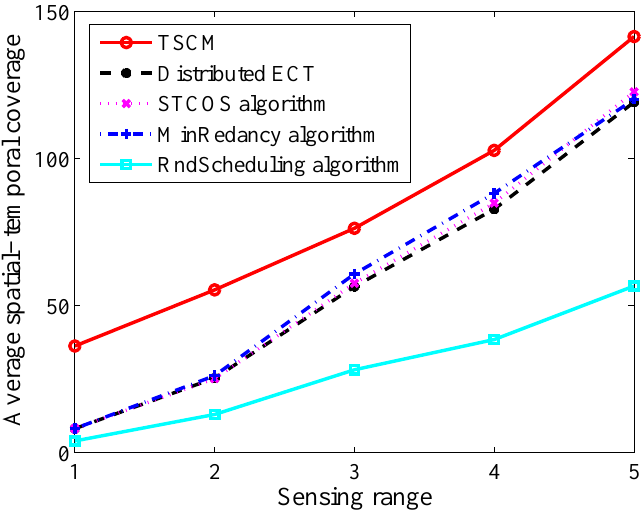
Figure 6. The average spatial-temporal coverage versus different sensing